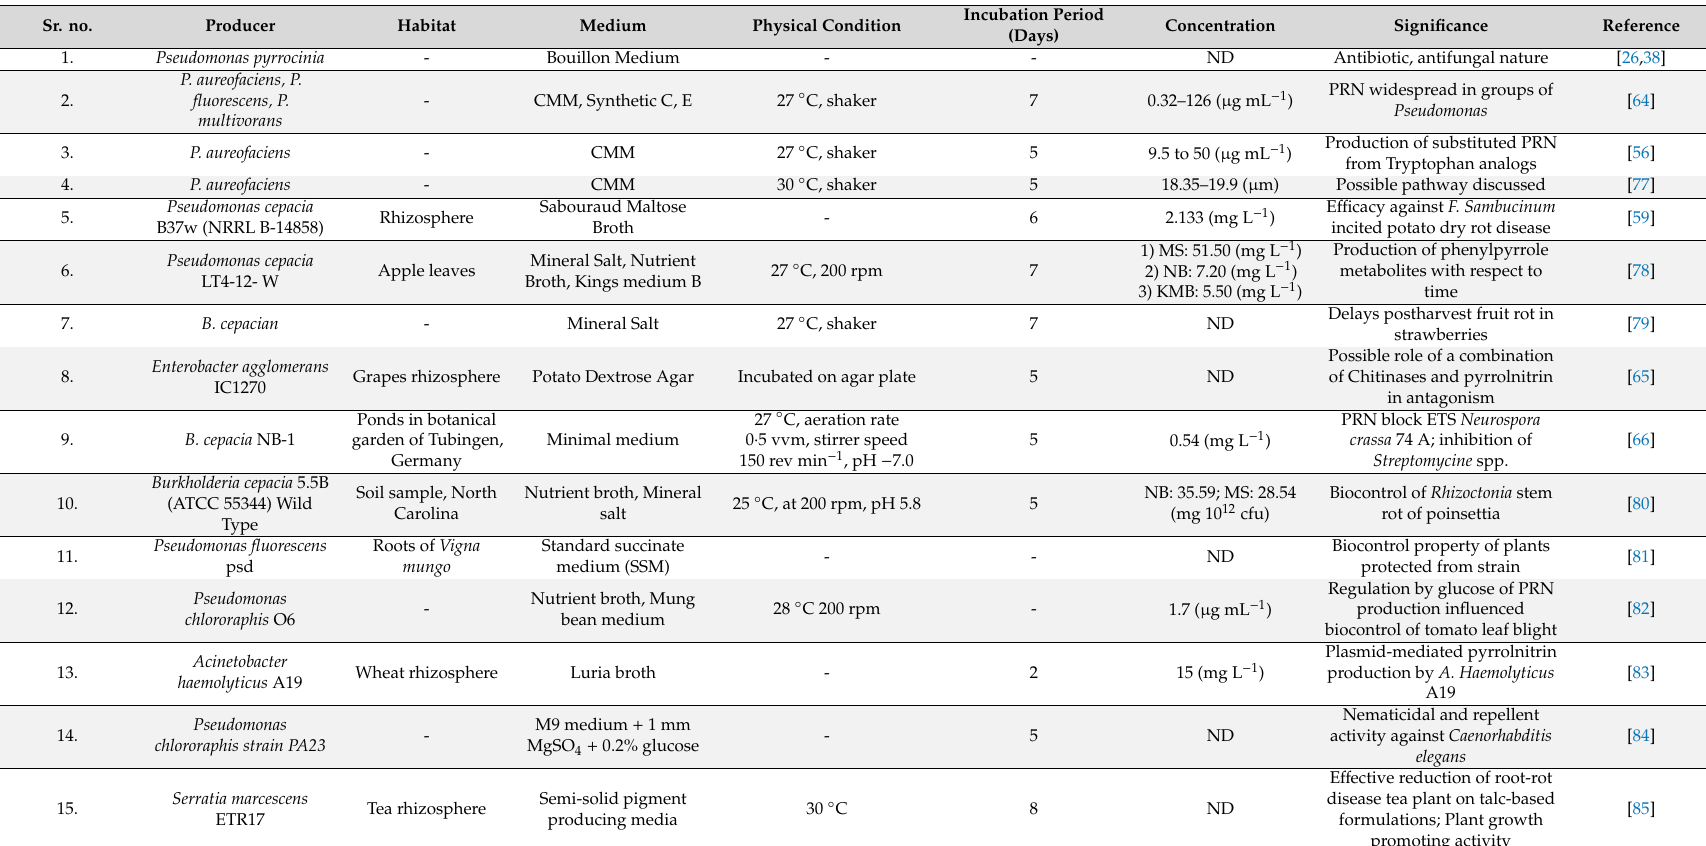
Table 3. Characteristics of PRN production by di ff erent microbial species inhabiting several